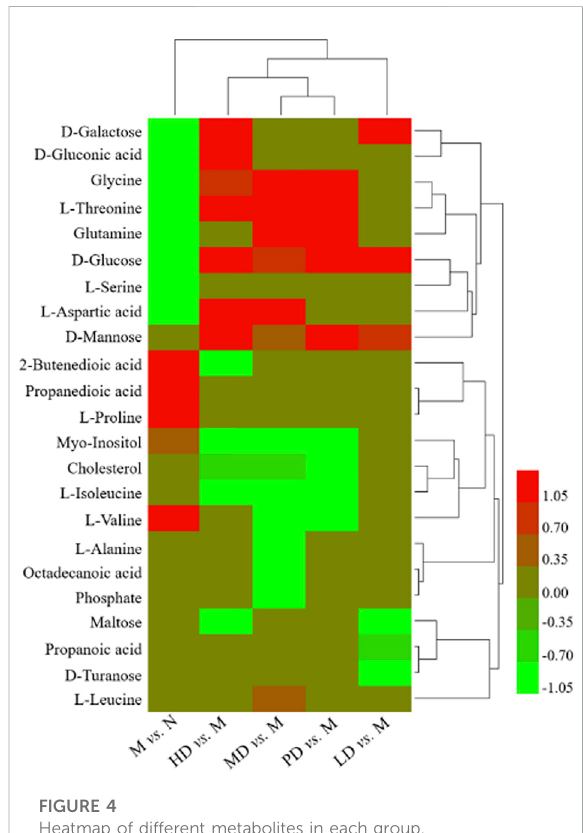
FIGURE 4 Heatmap of different metabolites in each